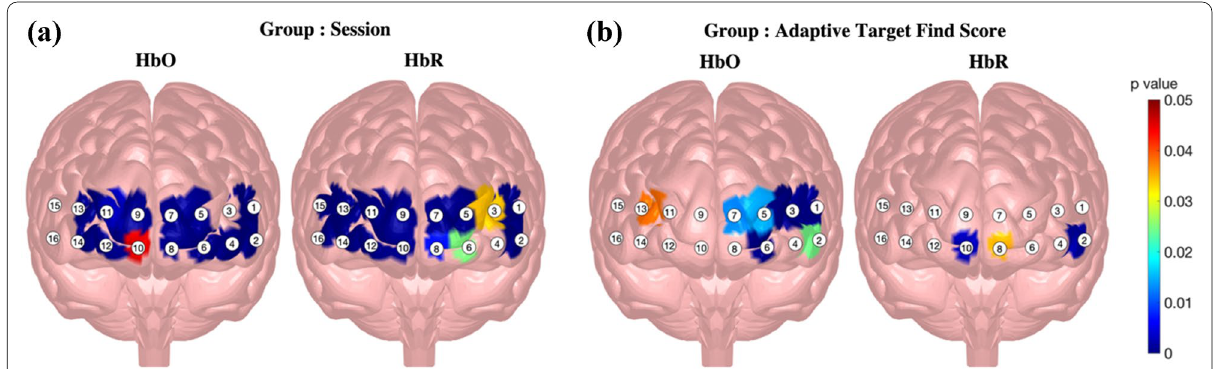
Fig. 5 Significance of changes in mean fNIRS measures per channel and biomarker. A Interactions effects between Group and Session. B Interaction effects between Group, Session and Adaptive target find score. Channels with overlayed coloring indicate significance of the associated term at α less than